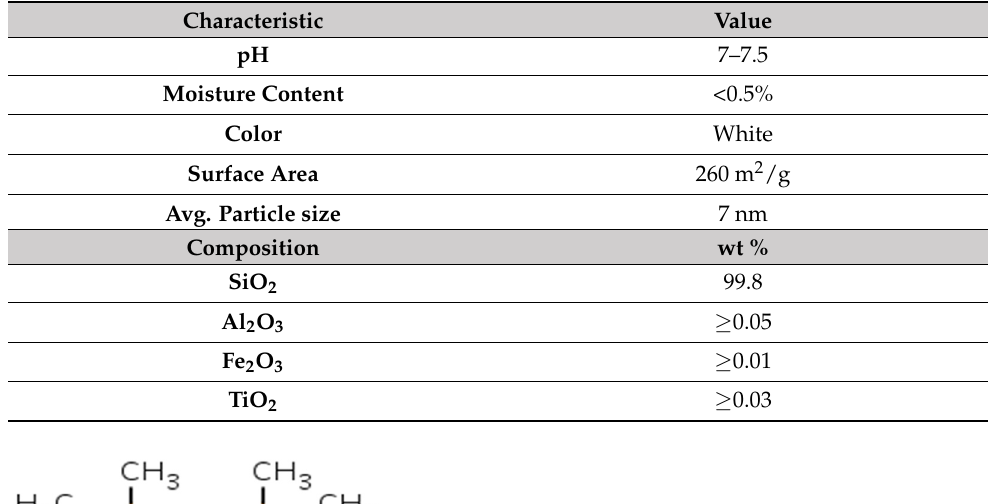
Table 1. Characteristics of hydrophobic fumed silica.